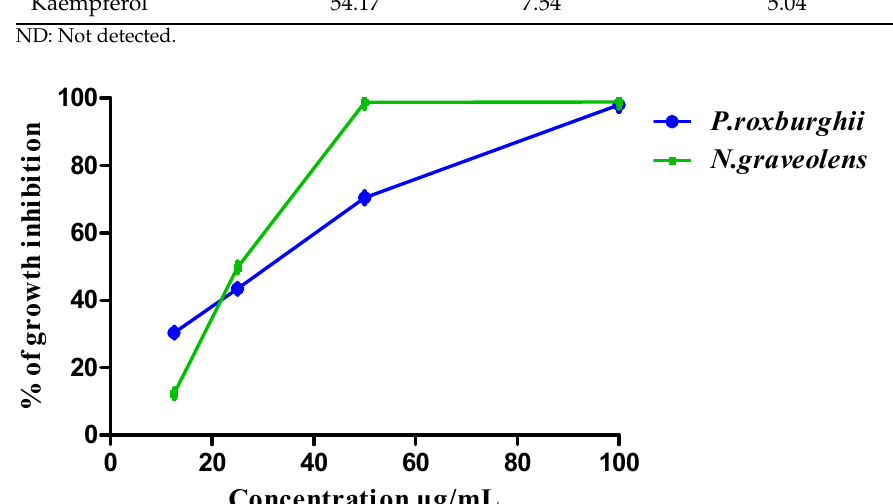
ND: Not detected.